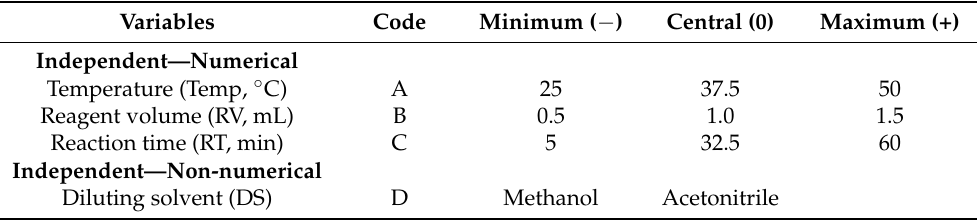
Table 1. Variables affecting CTC formation reaction. Measured response (Y ctc ) is absorbance at 843 nm.